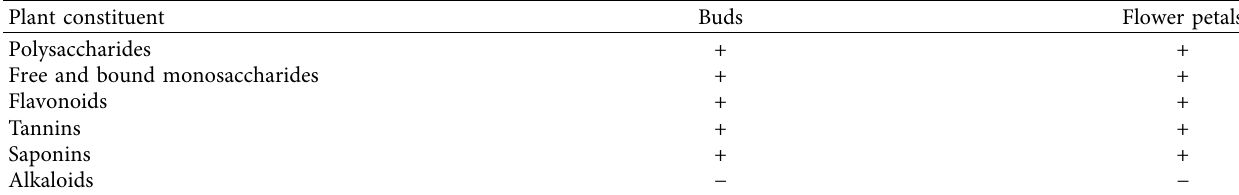
Table 2: Preliminary phytochemical analysis of the flower petals and buds of R. damascena.